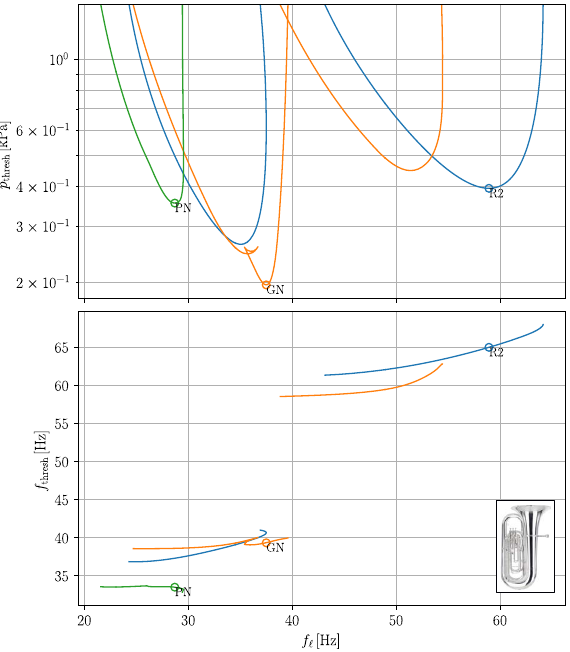
Figure 7. Top and bottom plots represent respectively the threshold pressures and threshold frequencies given by the locus of the Hopf points (blue) and the locus of the saddle-node bifurcation points (orange and green) with respect to the lips ’ resonance frequency in the case of the B [ -contrabass tuba (colors correspond to the ones in Figure 6). The circles identify the local minimum of blowing pressure for each note, namely the pedal note (PN), the ghost note (GN), and the second regime (R2). In the case of the second Hopf bifurcation, the easiest note playable is given by the minimum of the Hopf points ’ locus (blue curve), since its minimal threshold mouth pressure is lower than the one given by the saddle-node bifurcation points ’ locus (orange curve). On the contrary, in the case of the ghost note it is given by the minimum of the saddle-node bifurcation points ’ locus (orange